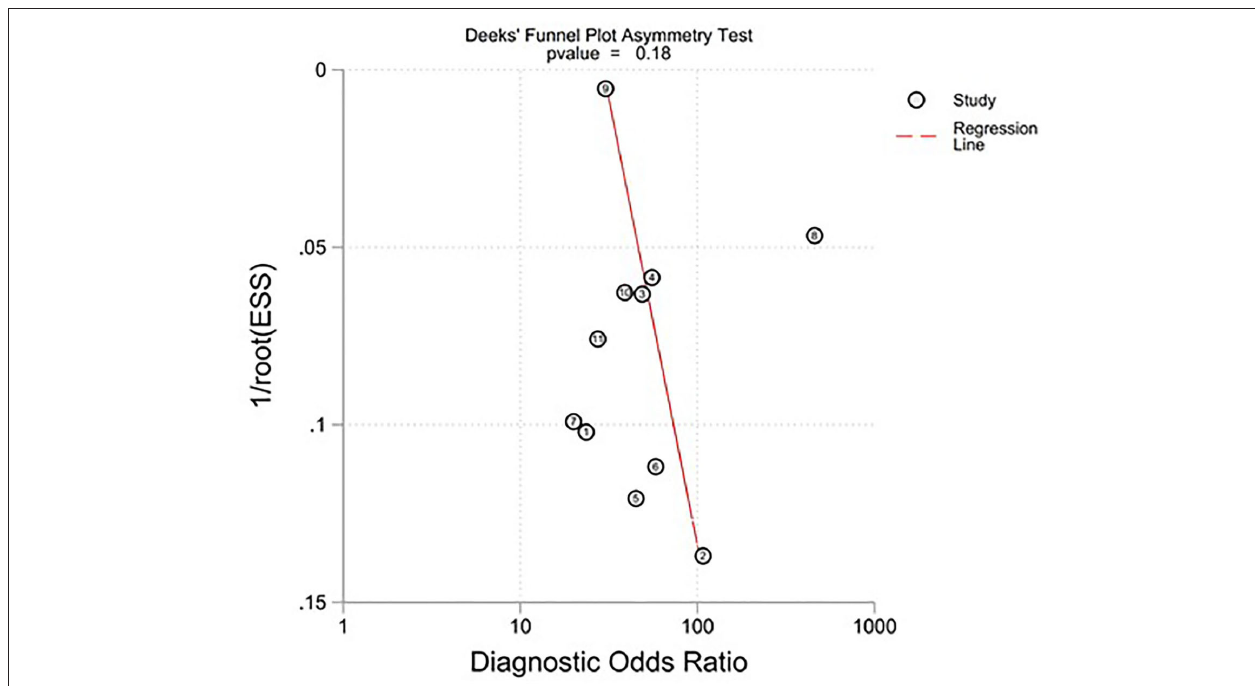
FIGURE 7 | Deek’s Funnel Plot asymmetry test of all included